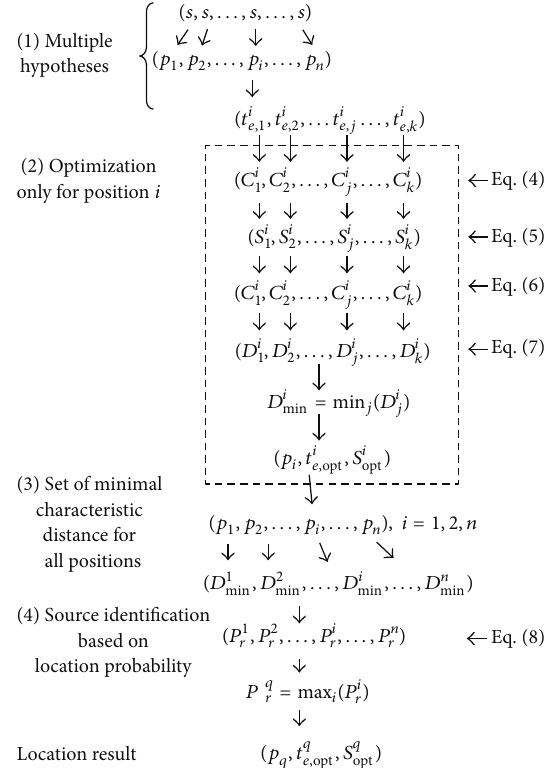
Figure 1: Implementation steps for a source